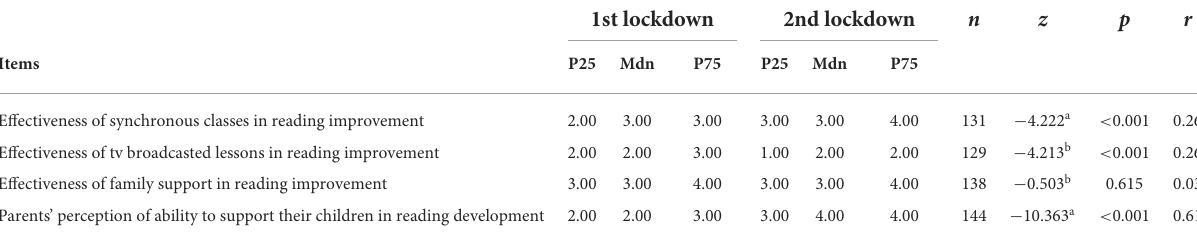
TABLE 3 Parents’ perceptions on the efficacy of the practices and learning support in children’s reading skills during the remote